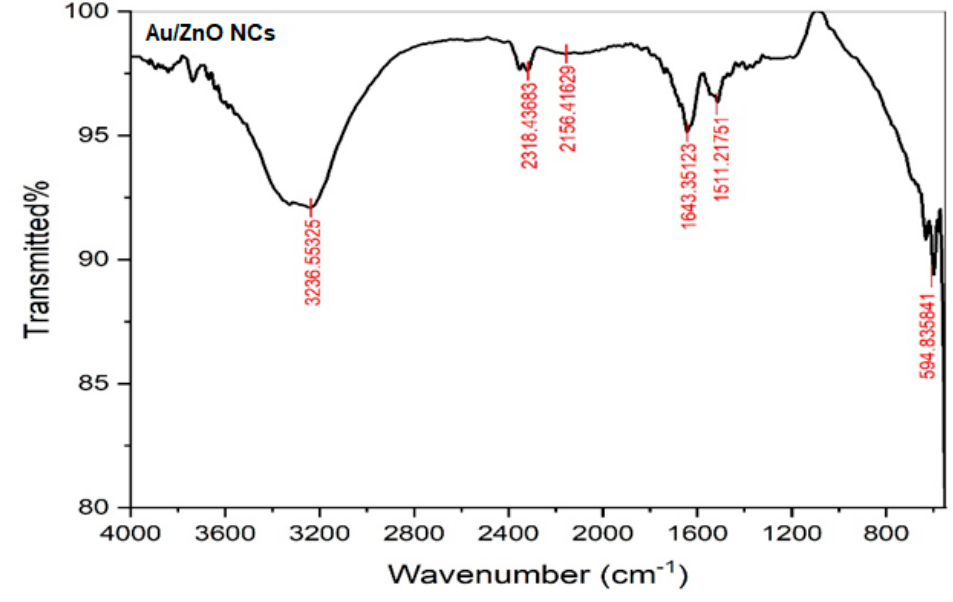
Figure 4. FTIR spectrum of Au/ZnO NCs prepared by LA at 800 mJ.